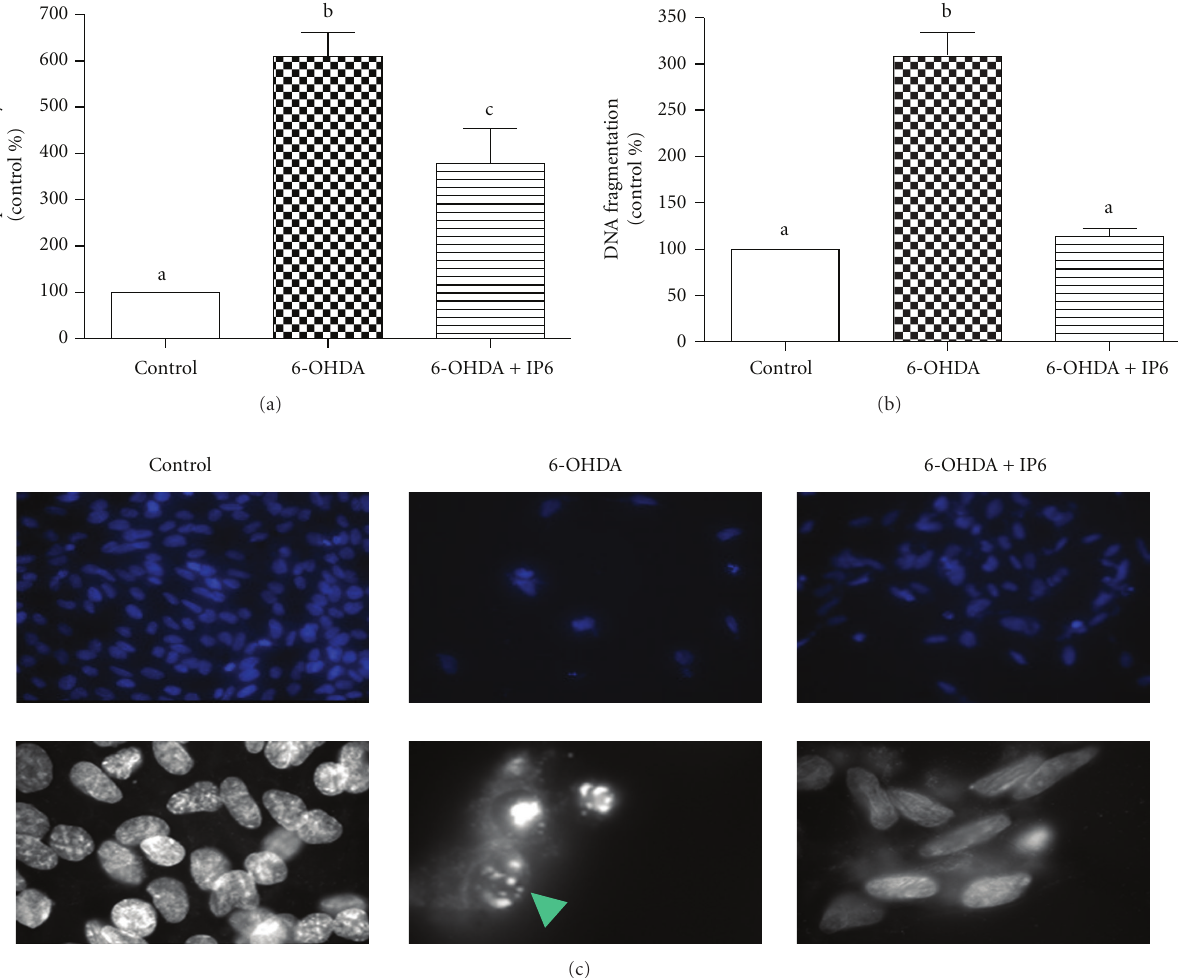
Figure 1: Protection of IP6 (30 μ mol/L) against 6-OHDA-induced apoptosis in vitro cell culture model. Cell apoptosis was measured as caspase-3 activity (FU/mg protein, (a) n = 10 from two separate experiments) and DNA fragmentation (AU/mg protein, (b) n = 3 from one experiment) and Hoechst nuclear staining (c). ANOVA with Tukey’s Multiple Comparison test was used to detect the di ff erences among the treatments in (a) and (b), and means with di ff erent letters were significantly di ff erent ( P < . 05). The top panel in C represents 20x magnification and the bottom panel represents 60x magnification. Apoptotic nucleus is indicated with an